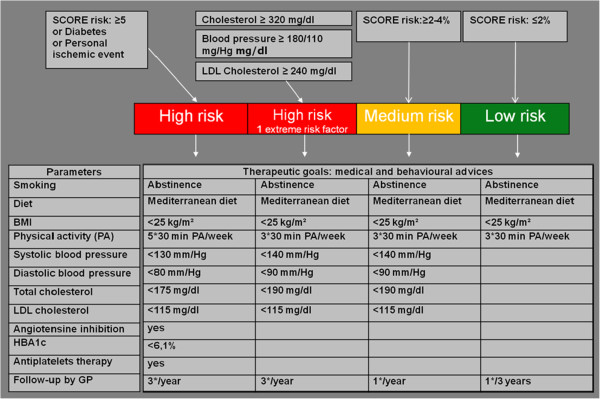
Guidelines for cardiovascular prevention.